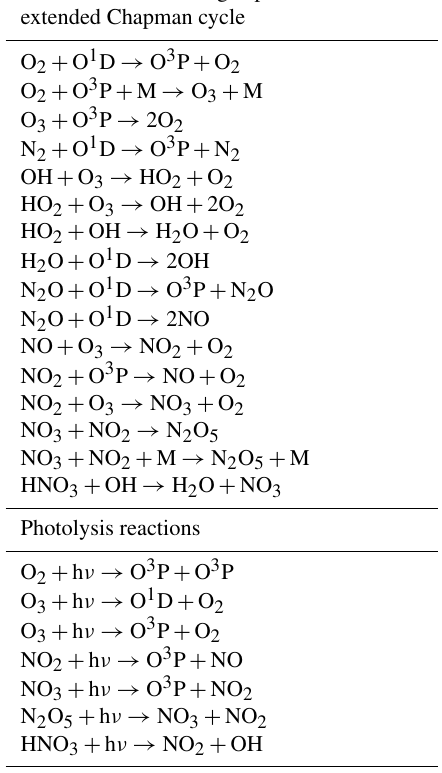
Table 1. Summary of the chemical reactions used for the extended Chapman cycle simulation.